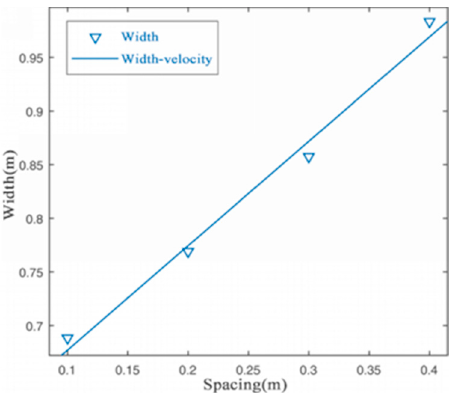
Figure 16. The correlation curve of scour width and jet spacing.